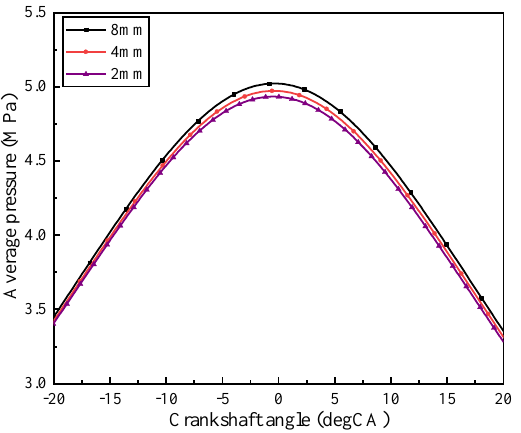
Figure 2. Average pressure obtained from cold flow calculation for three grid sizes (CR = 9.5).